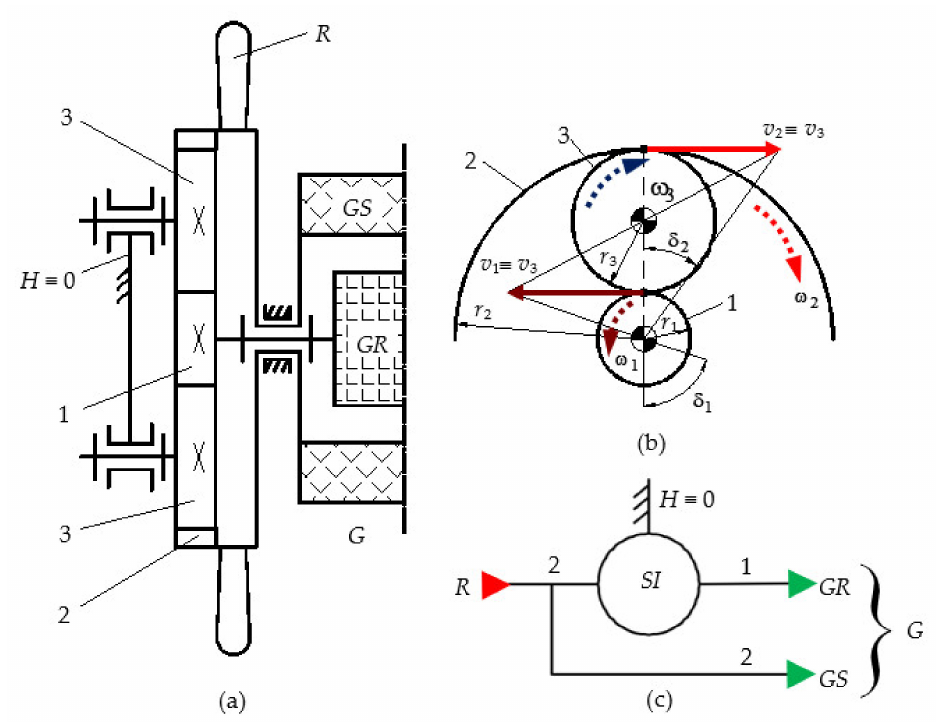
Figure 1. Single-rotor wind turbine with counter-rotating electric generator: ( a ) conceptual scheme; ( b ) kinematic scheme (upper-half front view); and ( c ) block